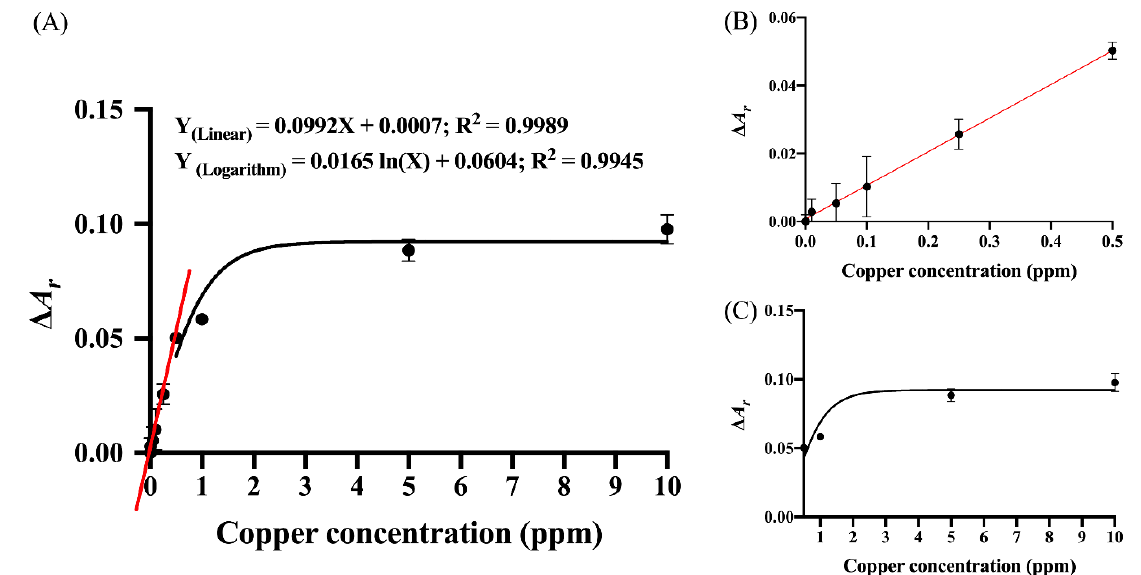
Figure 5. ( A ) The plot of Δ A r against the Cu 2+ concentration in the range of 0 – 10 ppm. Each experiment was performed in triplicate. The linear regression line for Cu 2+ concentration in the range of 0.03 – 0.5 ppm is indicated with a red line. The logarithmic regression line for Cu 2+ concentration in the range of 0.5 – 10 ppm is indicated with a black line. Insets ( B ) and ( C ) are the expanded view of the linear and logarithmic regression lines, respectively. The linear and logarithmic equations along with the corresponding correlation coefficients are indicated in ( A ). Table 1. Comparison of colorimetric detection probes for Cu 2+ based on AuNPs and AgNPs, and this Thy-AuNP-AgNP hybrid sensing system.